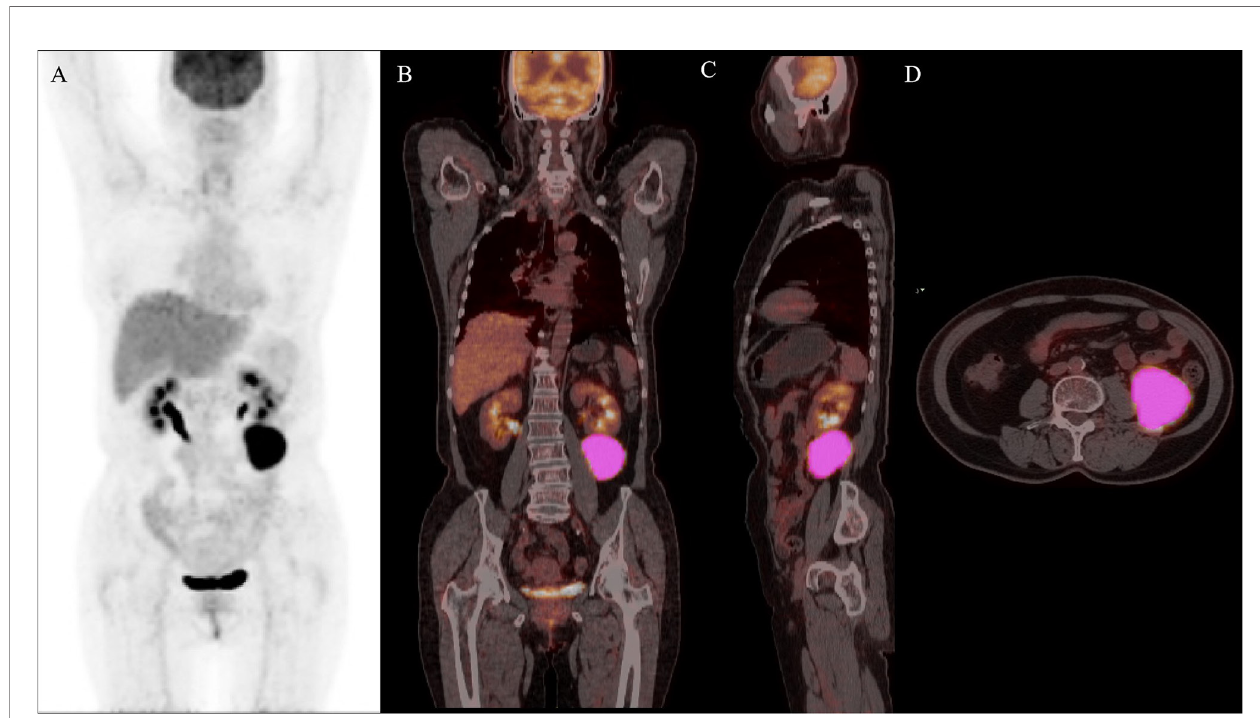
FIGURE 1 | Maximal intensity projection image (A) , coronary image (B) , sagittal image (C) , and transaxial images (D) of 18 F-FDG PET/CT showing an example of VOI for measuring imaging features of BCL. A 68-year-old woman with stage IV DLBCL. MIP image showing metabolically active left abdominal lesion. 3D VOI was manually drawn with the LIFEx segmentation tool using the previously recommended SUV max threshold of